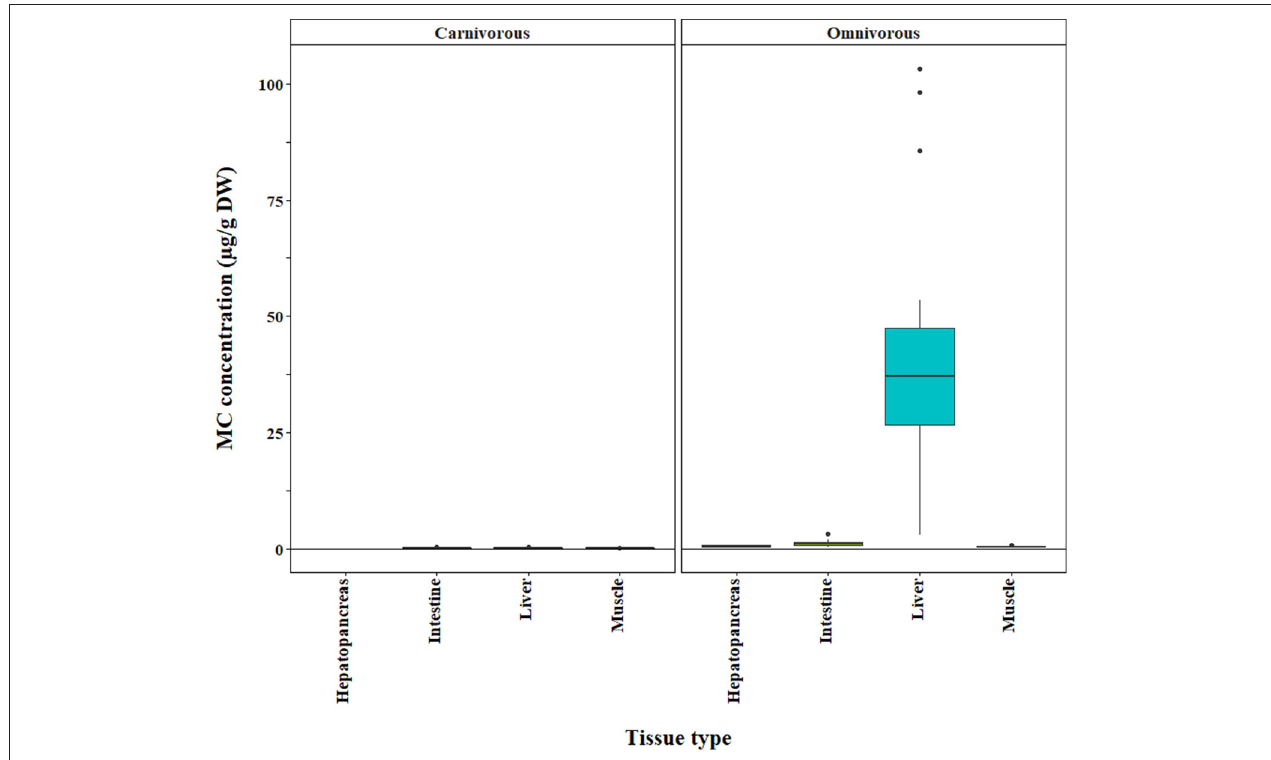
FIGURE 5 | Microcystin (MC) concentrations in tissues of carnivorous and omnivorous fishes based on PP2A method. The raw data are shown.